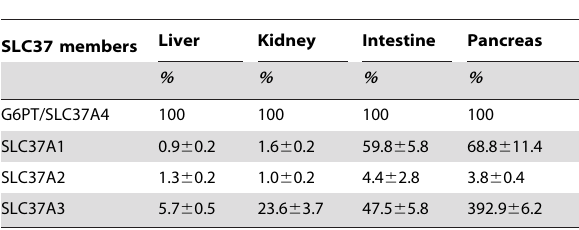
Table 1. The mRNA levels of SLC37 members, relative to G6PT/SLC37A4, in mouse liver, kidney, intestine, and pancreas.